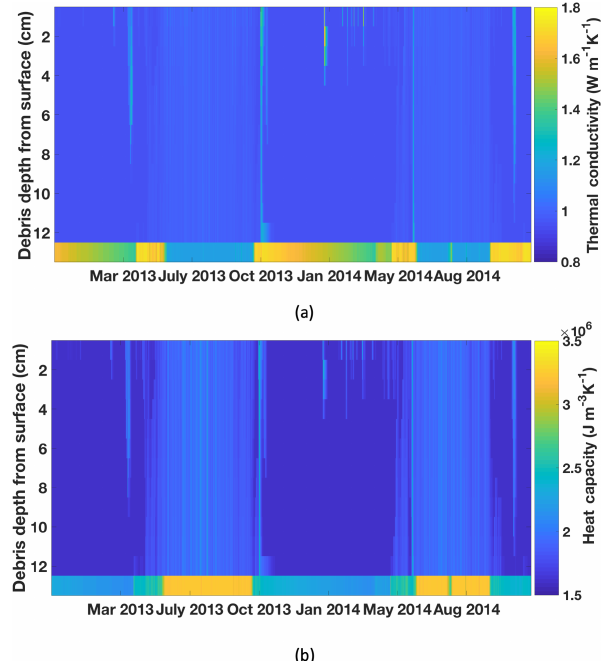
Figure 9. Temporal evolution of (a) thermal conductivity and (b) volumetric heat capacity according to debris moisture amount, phase, and gradient. Figure S5 gives a different perspective on the evolution: temporal changes in the debris surface, middle, and base layers, as well as the 2013 monsoon season (JJAS) diurnal averages for each